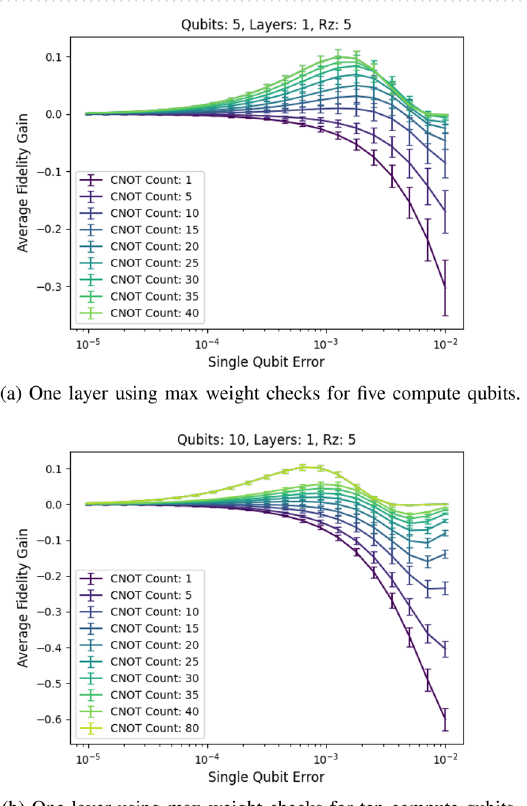
Figure 16. Ten-qubit circuits with 5 rz gates. We used a single layer of low weight checks. The 80 cnot count case matches the cnot count to qubit ratio of the five-qubit case with 40 cnot gates. ( a ) The peak fidelity gain is about ten percentage points. It occurs at a single-qubit error of about 0.000891 (0.00891 two-qubit error).